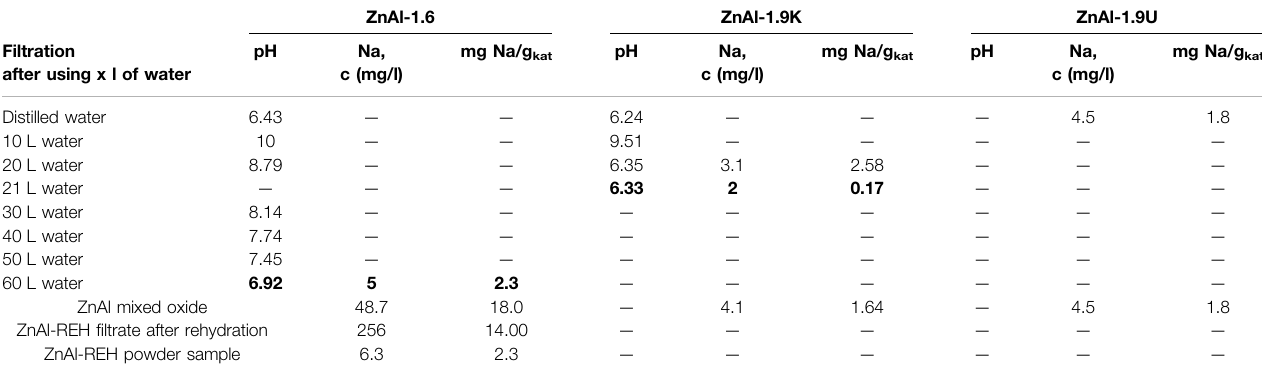
TABLE 3 | Content of Na and pH value during the preparation of ZnAl hydrotalcites, ZnAl mixed oxides and ZnAl reconstructed material.